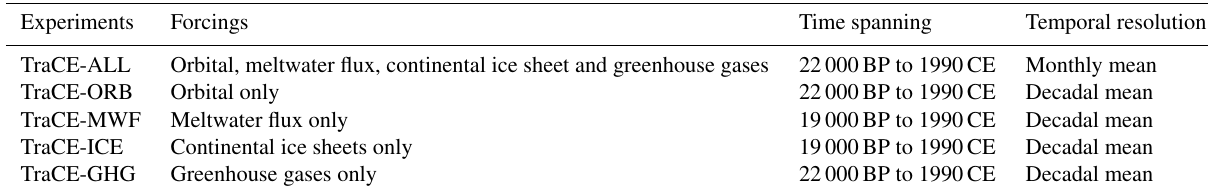
Table 1. The information of the experiments used in this study. Experiments